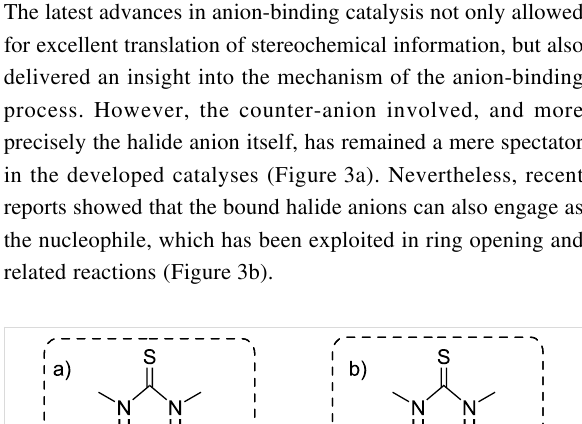
In general, the idea of enantioselective ring opening produces two fixed stereocenters during one synthetic operation,